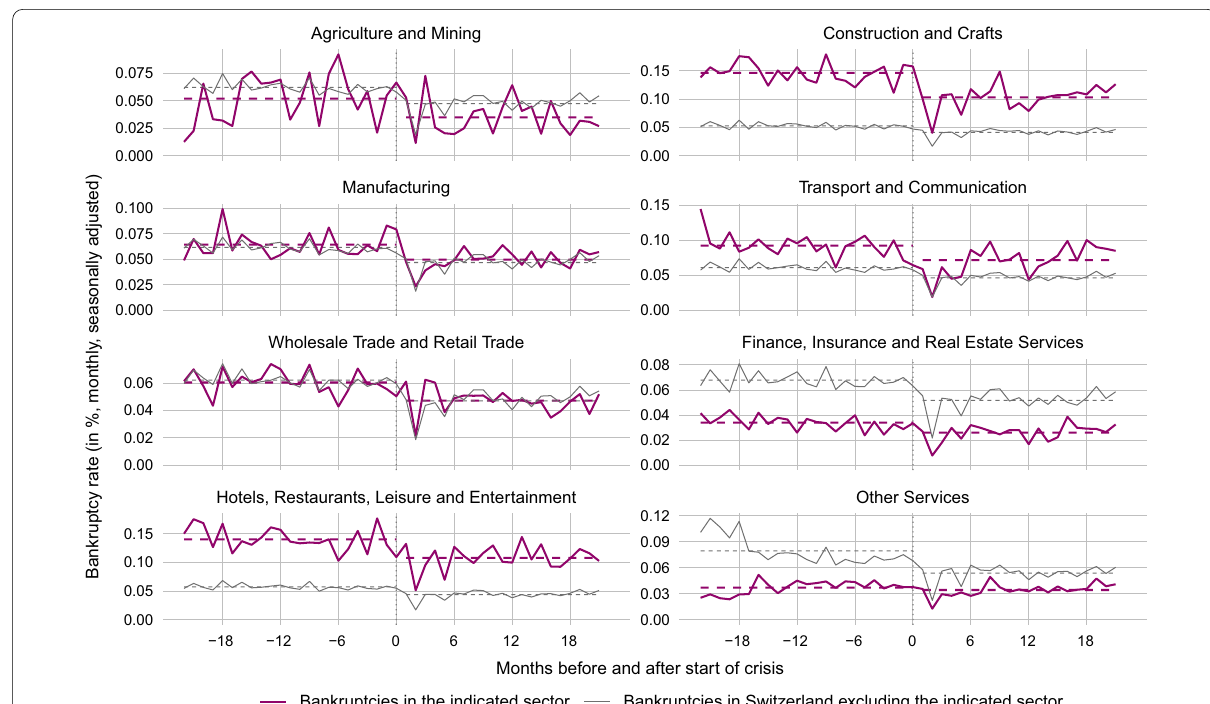
Fig. 6 Bankruptcies in different industries before and after start of COVID-19. Notes : The figure shows the monthly bankruptcy rate ( seasonally adjusted frequency of firm bankrupcties excluding SCO Art. 731b cases divided by the stock of firms) in different industries of the Swiss economy before and after the start of the COVID-19 crisis as compared to the bankruptcy rate in the respective rest of the economy. The last month before the crisis start ( month 0) is February 2020. The dotted lines are the average bankruptcy rates over the 22 months before or after the crisis =